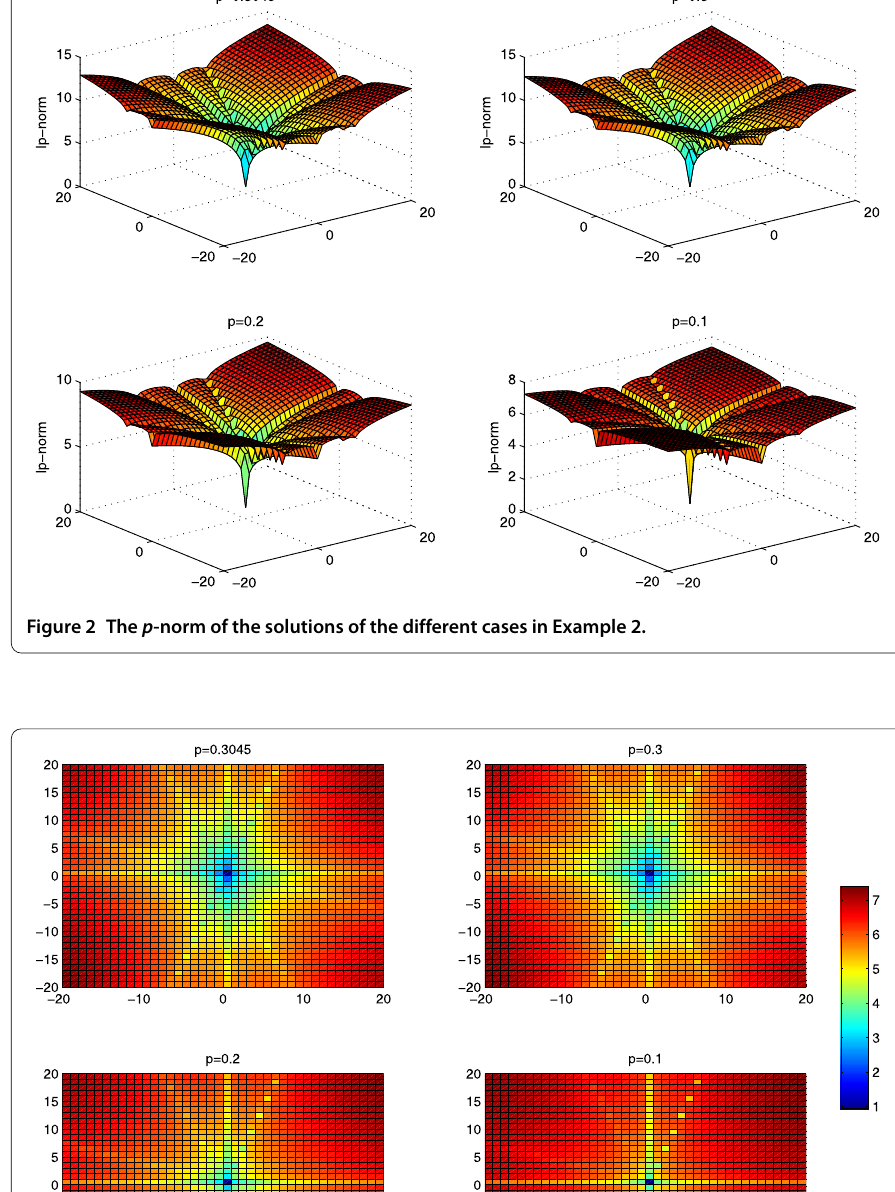
of p ∗ ( A , b ) such that l p -minimization is equivalent to l 0 -minimization. Although it is NP- hard to find the global optimal solution of l p -minimization, a local minimizer can be done in polynomial time [24]. Chen [22] proved that h ( p , A , k ) < 1 is a necessary and sufficient condition for the global optimality of l p -minimization. Therefore, it is confident that